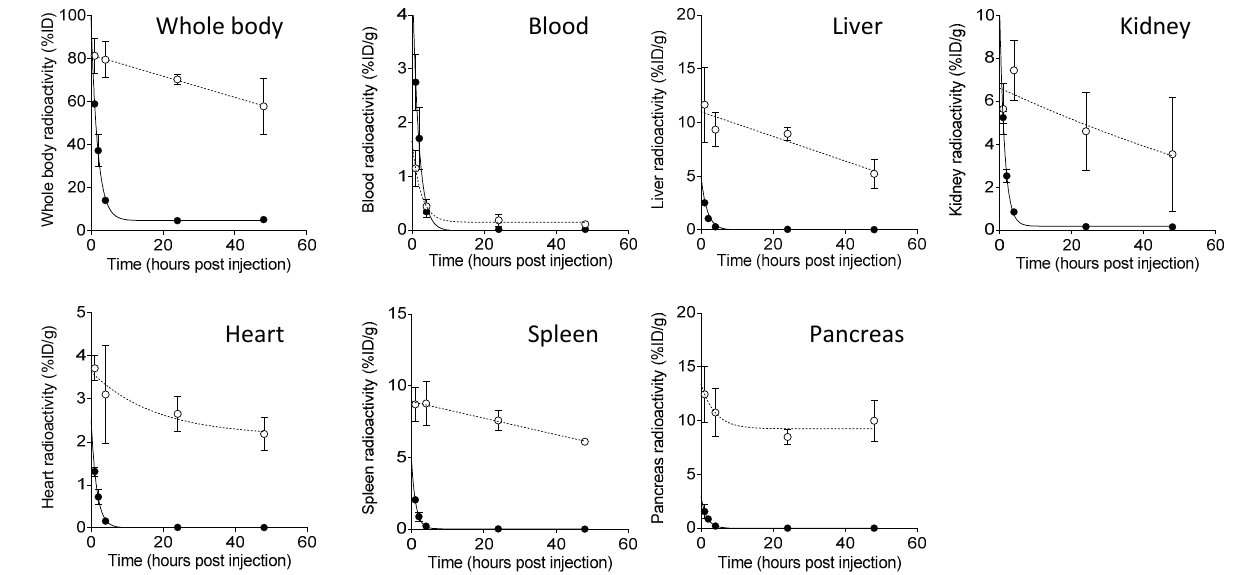
Figure 2. Whole body and organ retention of 125 I-p5+14 in healthy and AA amyloid-laden mice. Whole body and tissue radioactivity measurements were made by gamma counting and expressed as % injected dose (%ID) or percent injected dose per gram of tissue (%ID/g) of wild type (closed circles) or mice with systemic AA (open circles) of mice injected. Data, expressed as mean ± SD were fitted using a single or double exponential decay. N = 3 mice for each time